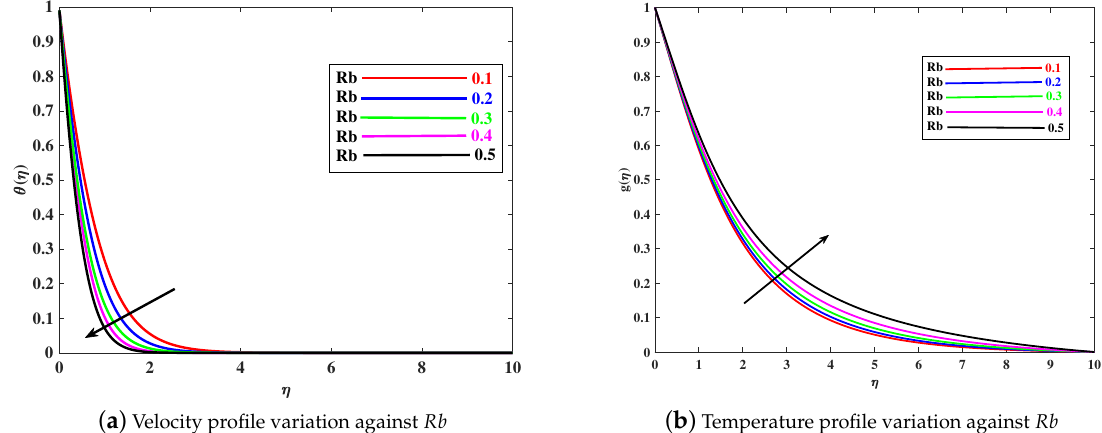
Figure 6. Effect of Rb to influence the momentum and thermal profile.